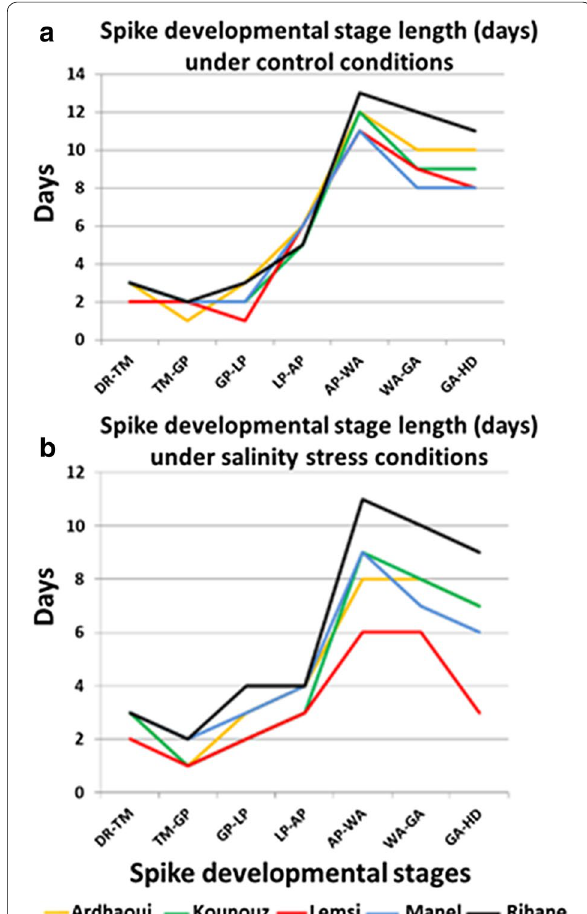
Fig. 3 Spike developmental stage length (Days) under control conditions ( a ) and salinity stress conditions ( b ). DR double ridge, TM triple mound, GP glume primordia, LP lemma primordium, AP awn primordium, WA white anther, GA green anther, HD